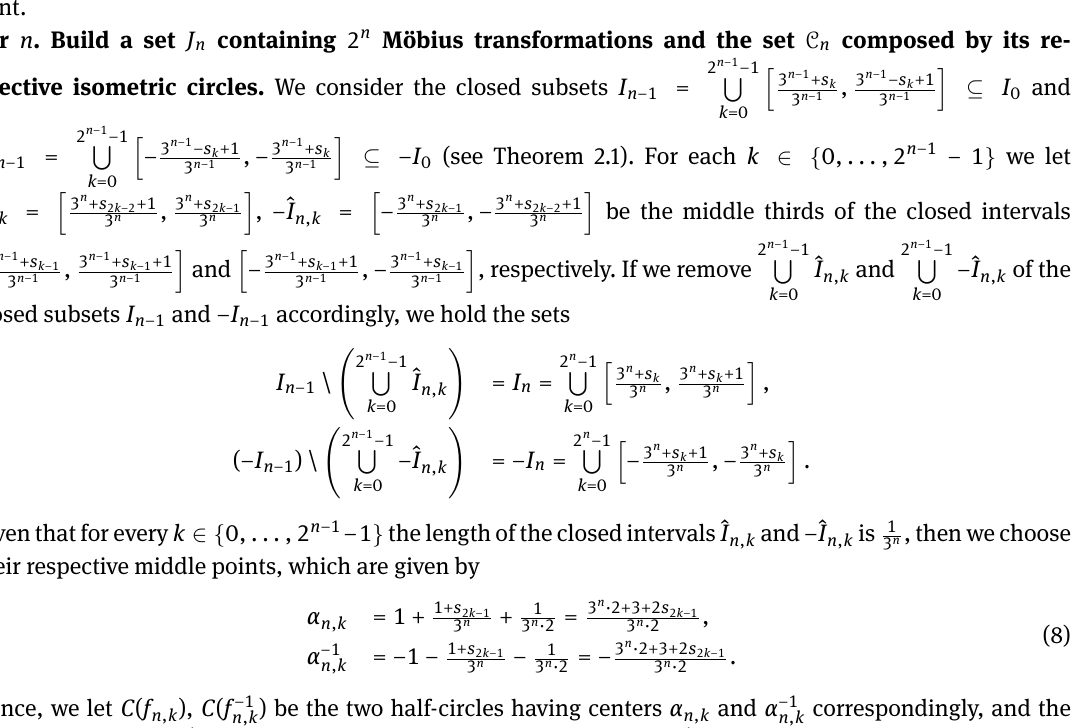
), respectively. Using Remark 2.9 we have c 1,1 = 1 1,1